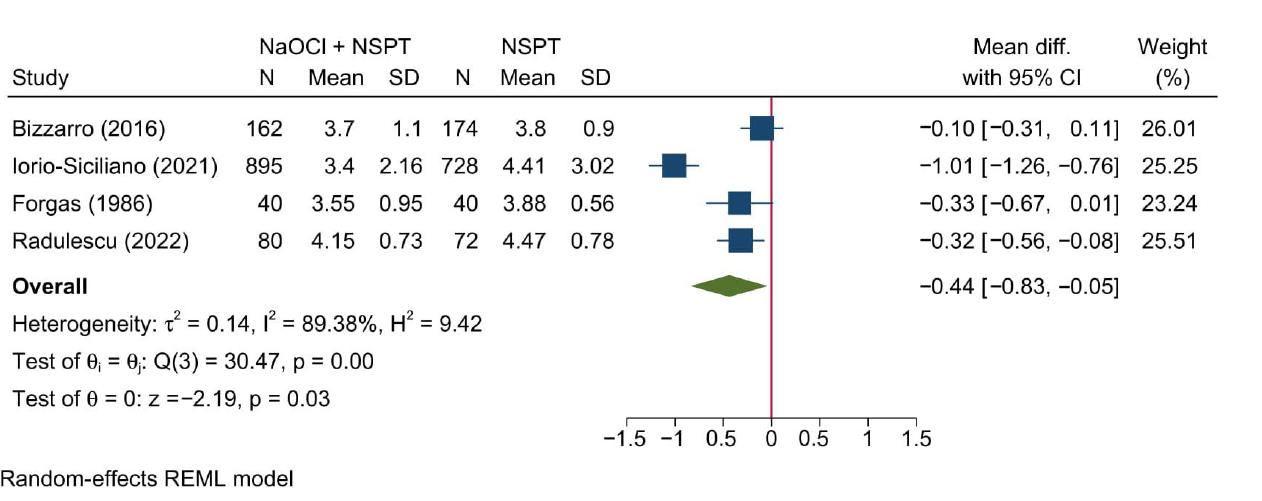
Figure 12. Forest plot showing the comparison between NaOCl + NSPT and NSPT alone regarding clinical attachment level [36,39,41,45].